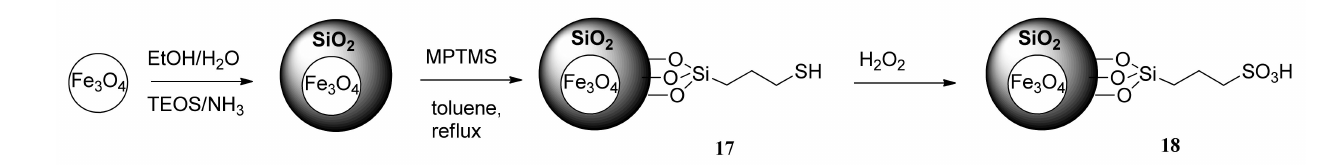
Figure 7. Production of propyl sulfonic magnetic silica based on ref [37].